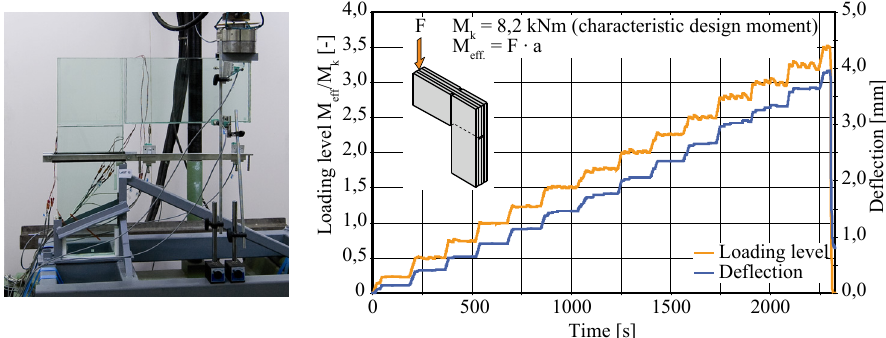
Figure 5: Verification of load bearing capacity: test set-up and results.